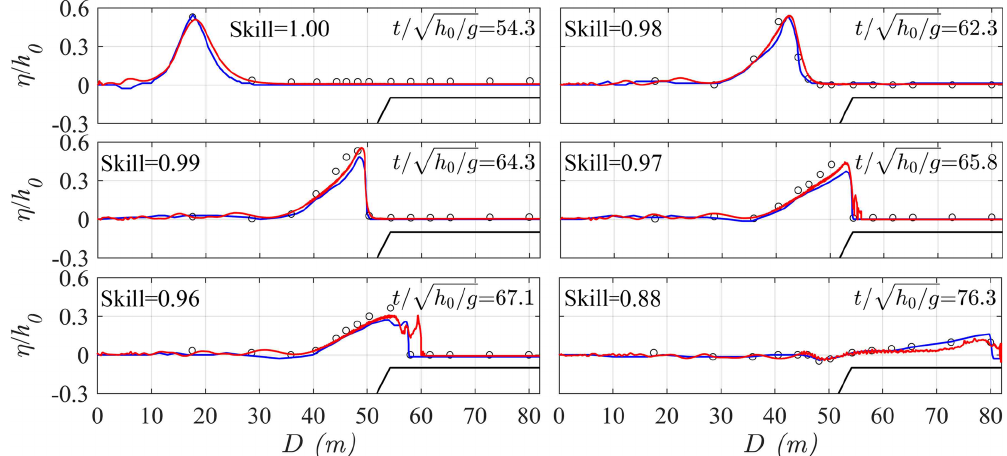
√ h 0 /g) for Scenario 1. Red lines – present